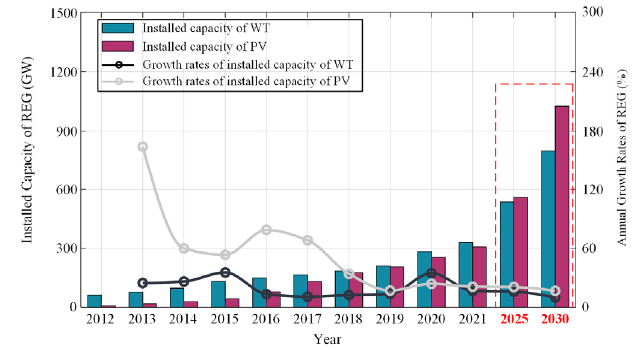
Figure 3. Installed capacity of WT and PV in China.